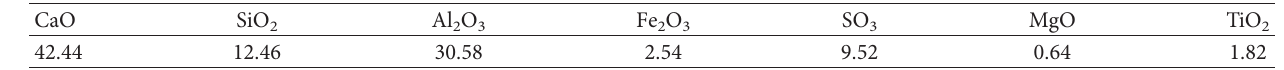
Table 3: Chemical composition of LASC